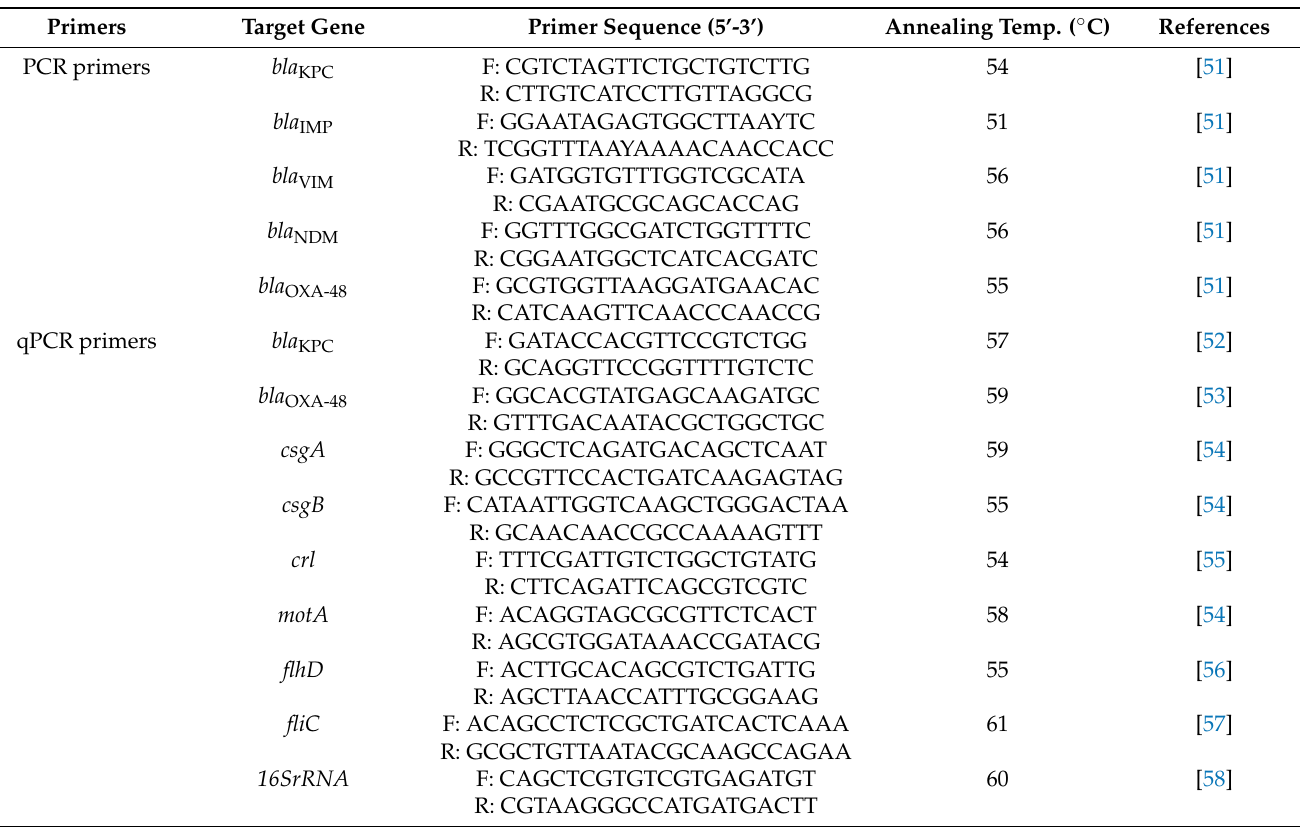
Table 4. PCR primers used in this